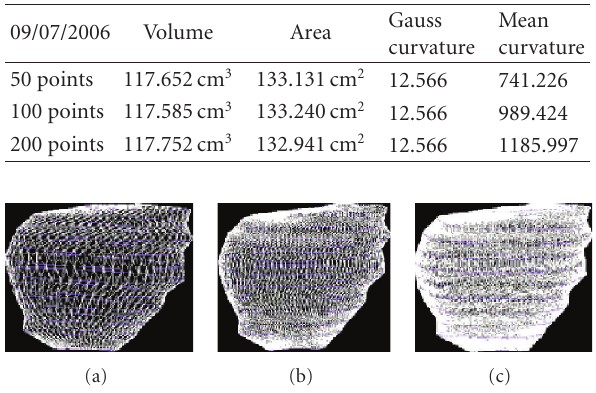
Figure 28: Patient 3. (a) 50 points on the contours, (b) 100 points on the contours, and (c) 200 points on the contours.